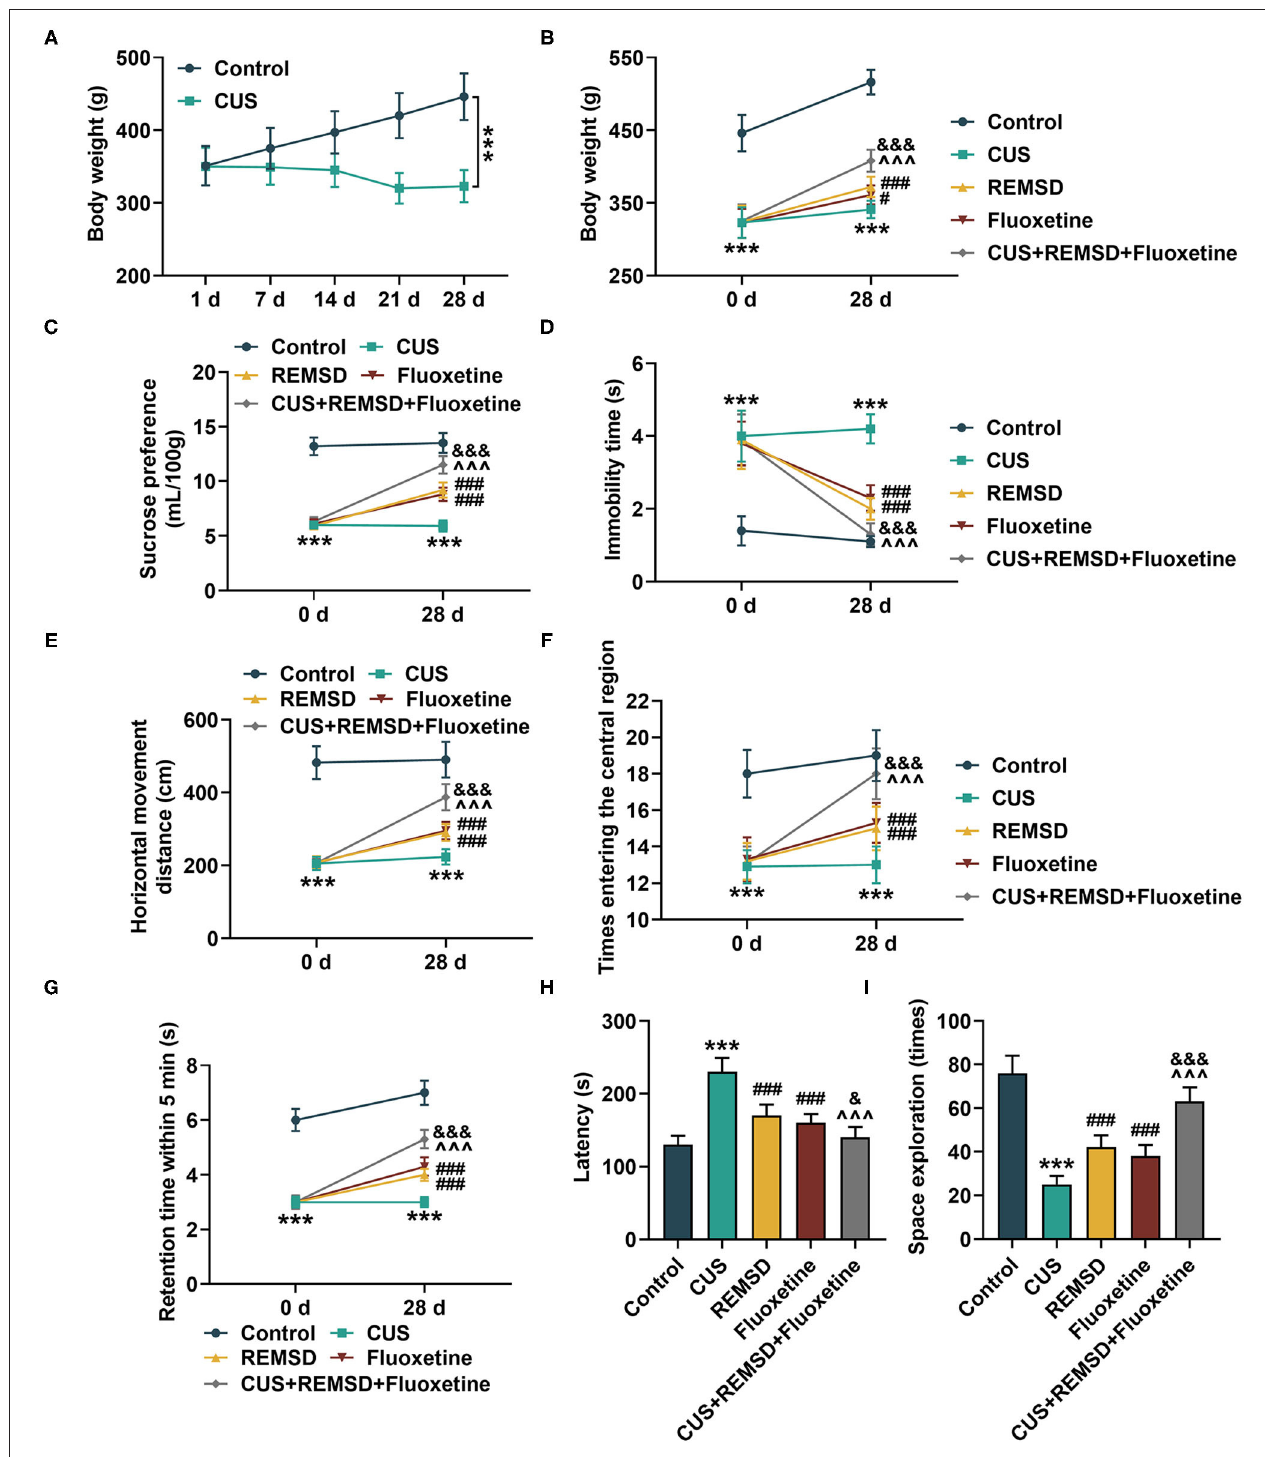
FIGURE 1 | Depression reduced body weight in rats, and sleep deprivation combined with fluoxetine increased body weight, and prompted behavior of rats with depression. (A) Body weight of rats subjected to depression model construction or not was measured on days 1, 7, 14, 21, and 28 after depression model construction ( n = 10 for each group). (B) Body weight of rats in control, CUS (depression), REMSD, fluoxetine, and REMSD + fluoxetine groups was measured. (C–E) Sucrose preference (C) , immobility time (D) and horizontal movement distance (E) , retention time in central area (F) , and numbers of rats entering central area (G) of rats in control, CUS (depression), CUS + REMSD, CUS + fluoxetine, and CUS + REMSD + fluoxetine groups were determined by Sucrose preference test and open